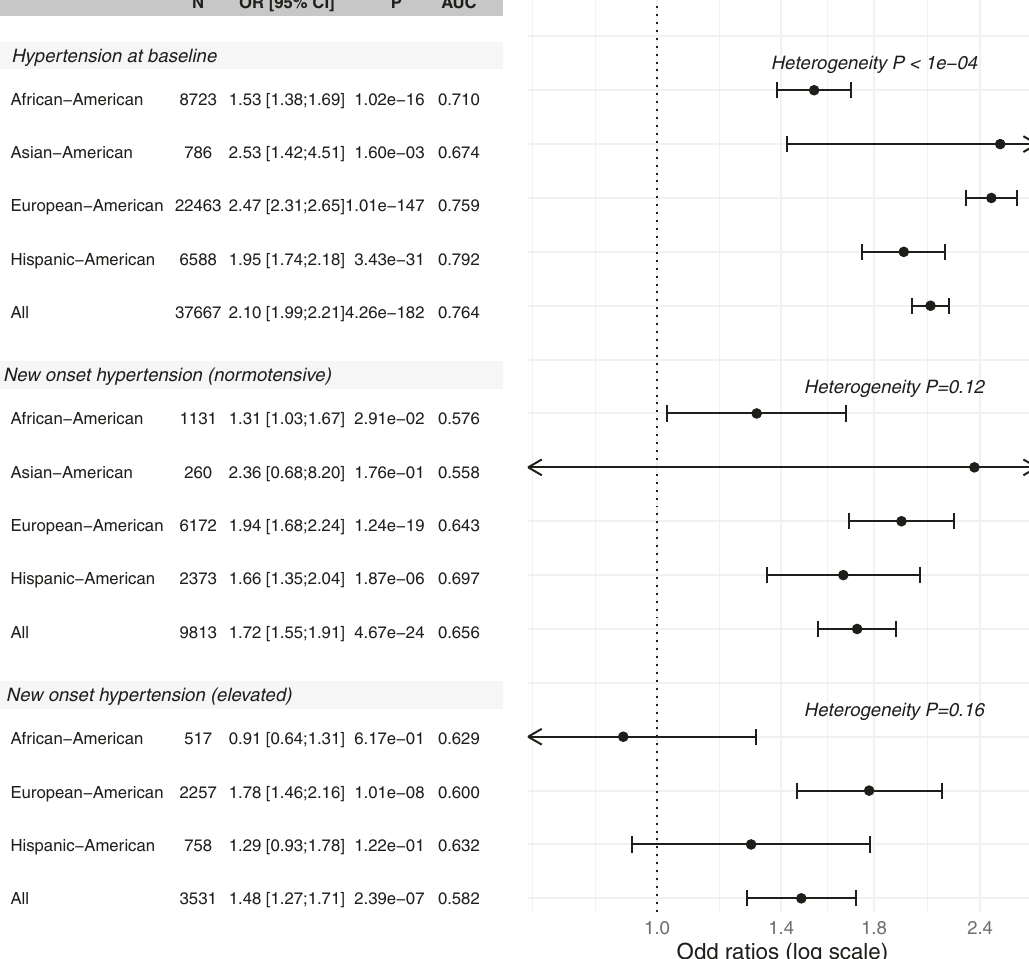
Fig. 5 Association of HTN-PRS with hypertension measures across race/ethnicities. The forest plot provides the association of the HTN- PRS with prevalent and incident hypertension in the stage 2 dataset, and within race/ethnic backgrounds. The top part corresponds to prevalence analysis at the baseline visit, the middle part corresponds to prediction of new onset hypertension in exam 2, among individuals who had normal BP at baseline, and the bottom part corresponds to prediction of new onset hypertension in exam 2, among individuals who had elevated BP at baseline. For each analysis the fi gure provides sample size (N), estimated odds ratio (OR) per 1 standard deviation (SD) increase of the PRS, and 95% con fi dence interval, p value of the association from the Wald test, and area under the receiver operating curve (AUC). Estimated ORs and con fi dence intervals (CIs) are provided both in the text (left part) and as points and error bars. Heterogeneity of estimated effects across race/ethnic groups was tested using the Cochran ’ s Q test accounting for correlation due to genetic relatedness across groups. The PRS association was estimated in a model adjusted for sex, age, age 2 , study site, race/ethnic background, smoking status, BMI, and 11 ancestral principal components. PRS SD was de fi ned according to the sampling SD of the PRS estimated in the entire TOPMed dataset. Statistical tests relied on the chi-squared distribution with either one degree of freedom (for effect size estimates) or 4 or 3 degrees of freedom (when testing heterogeneity across 5 or 4 strata of race/ethnic background) based on two-sided alternative